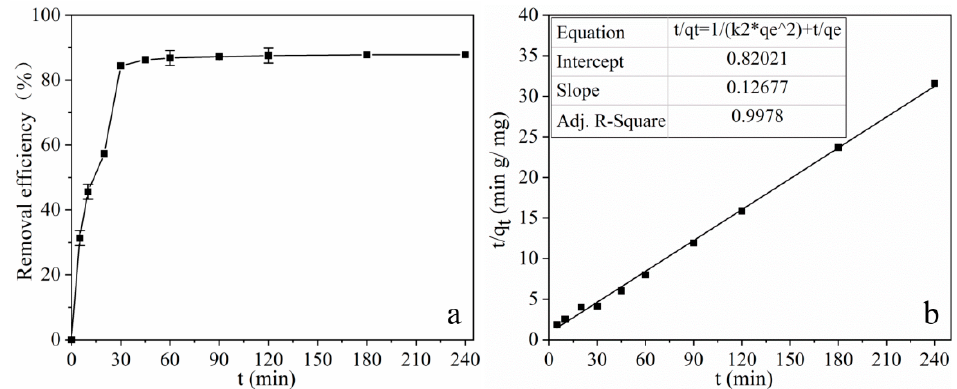
Figure 6. Effect of contact time on tetracycline removal ( a ) and pseudo-second-order kinetic plot ( b ) for the